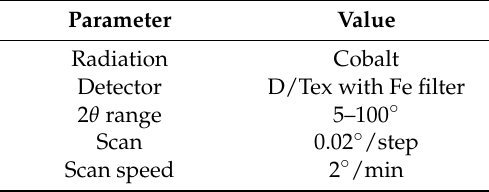
Table 3. X-ray diffraction